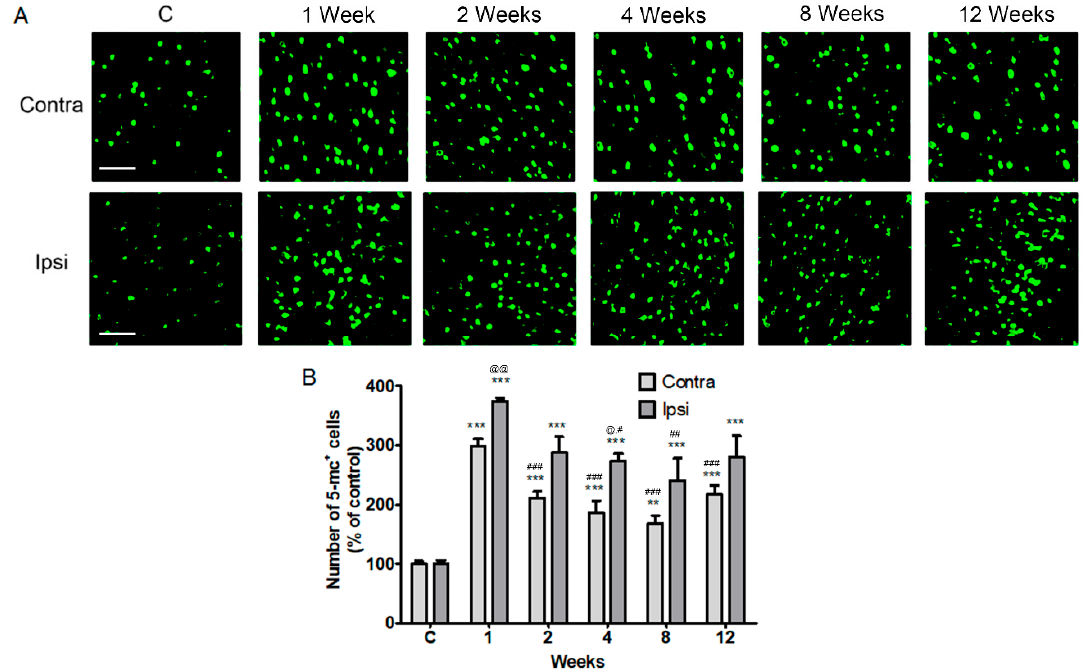
Figure 2. Localization of 5-methylcytosine (5-mc) in the contralesional and ipsilesional cortex after a stroke. ( A ) Fluorescent confocal microscopy shows that the 5-mc (green) is predominantly localized in the both the contralateral (contra) and ipsilateral (Ipsi) cortex from 1 week to 12 weeks after a stroke; ( B ) Quantification of 5-mc levels increased after a photothrombic ischemic stroke. Results are presented as the mean ± SEM, n = 6. ** p < 0.01; *** p < 0.001 vs sham control ( C ); # p < 0.05, ## p < 0.01, ### p < 0.001 vs. 1 day after stroke; @ p < 0.05, @@ p < 0.01 vs contralateral value at each time. Scale bars = 50 μ m.